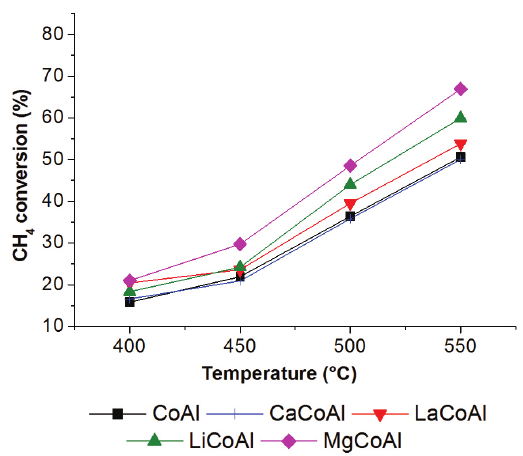
Figure 5. CH conversion vs. reaction 4